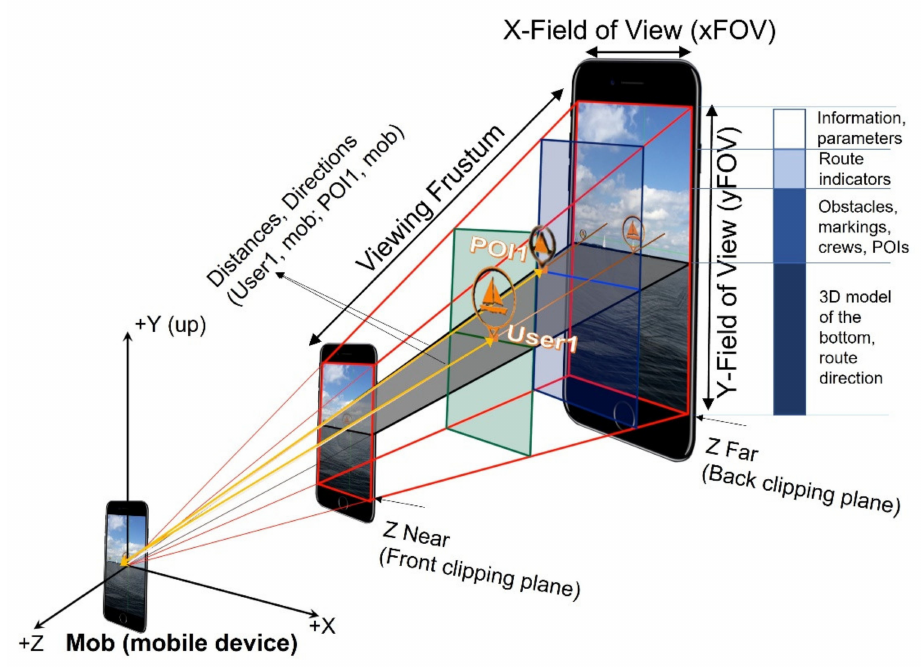
Figure 13. A visualisation of a real-world 3D coordinate system, determined by the viewing frustum created by the visual sensor, with the origin at the centre of the visual sensor. The X and Y axes are parallel to the screen. The Z-axis, which corresponds to the negative orientation direction of the visual sensor, is perpendicular to the screen. The AR layer layout concept for the MAR app prototype is on the